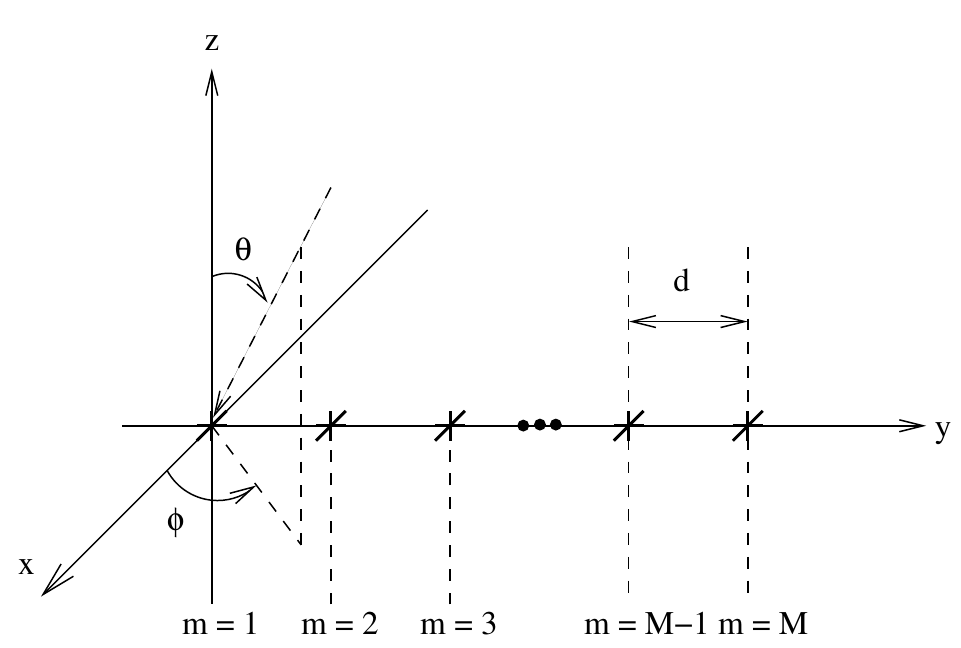
Figure 1. An array model with M potential tripole locations